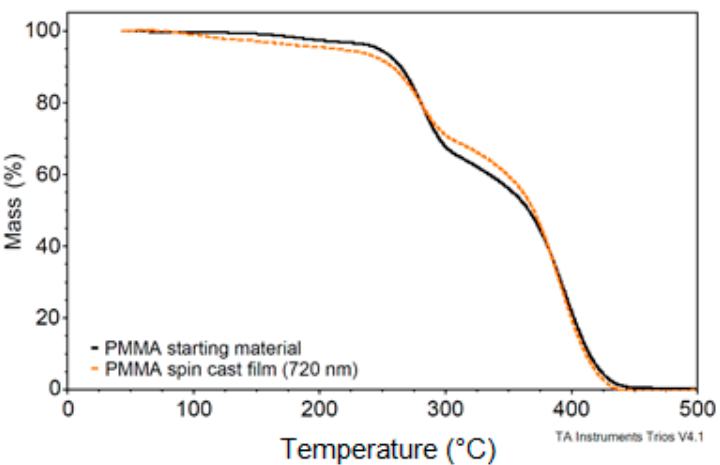
Figure 4. TGA thermogram of bulk PMMA and spin-cast film at 10 °C/min; 10.95 mg of PMMA powder and 0.28 mg of spin-cast film were used in the measurements.